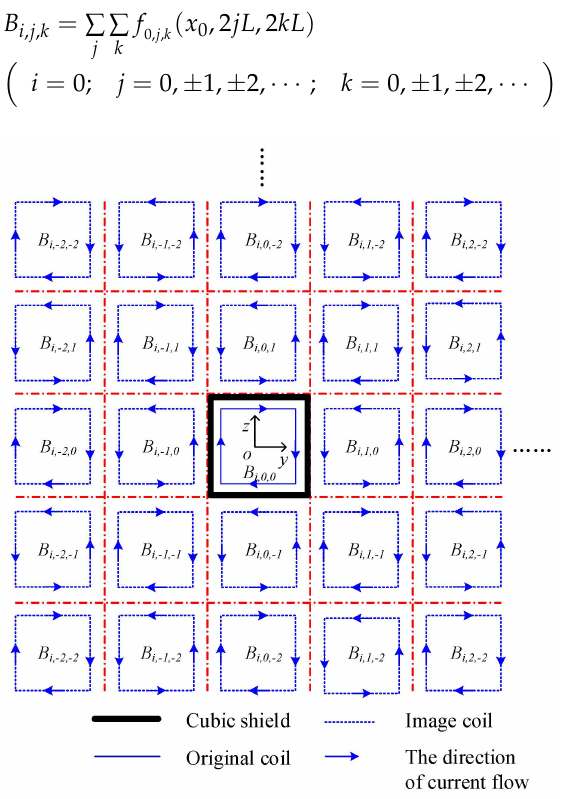
Figure 2. Image coils created for boundary conditions in xy planes and xz